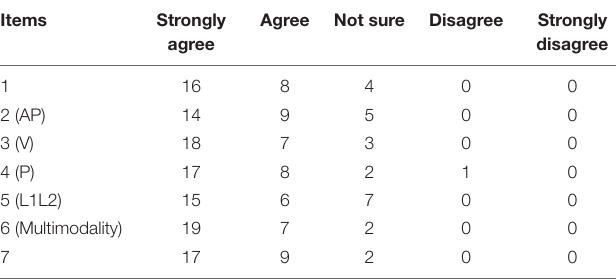
TABLE 7 | Results of questionnaire